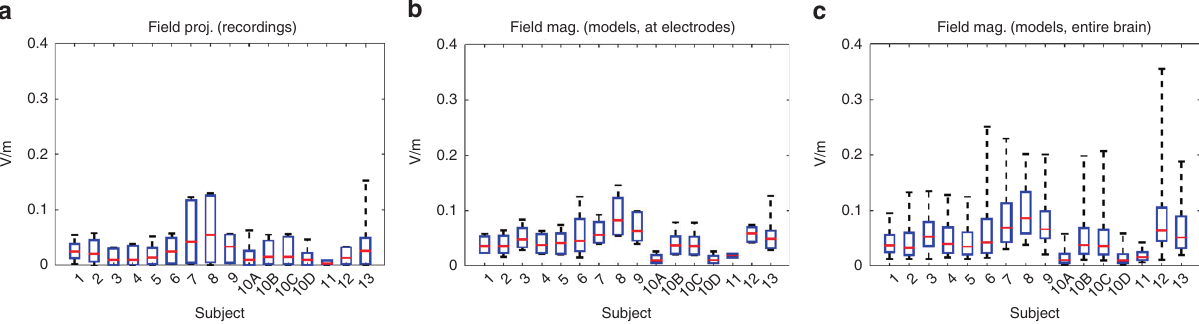
Fig. 2 Measured and estimated electric fi eld magnitudes. a Field projections calculated as the difference in recorded voltages between neighboring electrodes divided by electrode distance for each subject (with four montage orientations shown for S10), b fi eld magnitudes at electrode locations predicted by calibrated current- fl ow models, and c model-predicted fi eld magnitude across the entire brain. Red lines indicate the medians, and boxes span from 5 to 95% of the data, with whiskers extending to the minima and maxima. All values shown here correspond to the maximal current intensity applied for each subject during stimulation (S1: 1 mA; S2: 0.75 mA; S3: 1 mA; S4: 1 mA; S5: 1 mA; S6: 1 mA; S7: 1.5 mA; S8: 2 mA; S9: 1.5 mA; S10A: 0.3 mA; S10B: